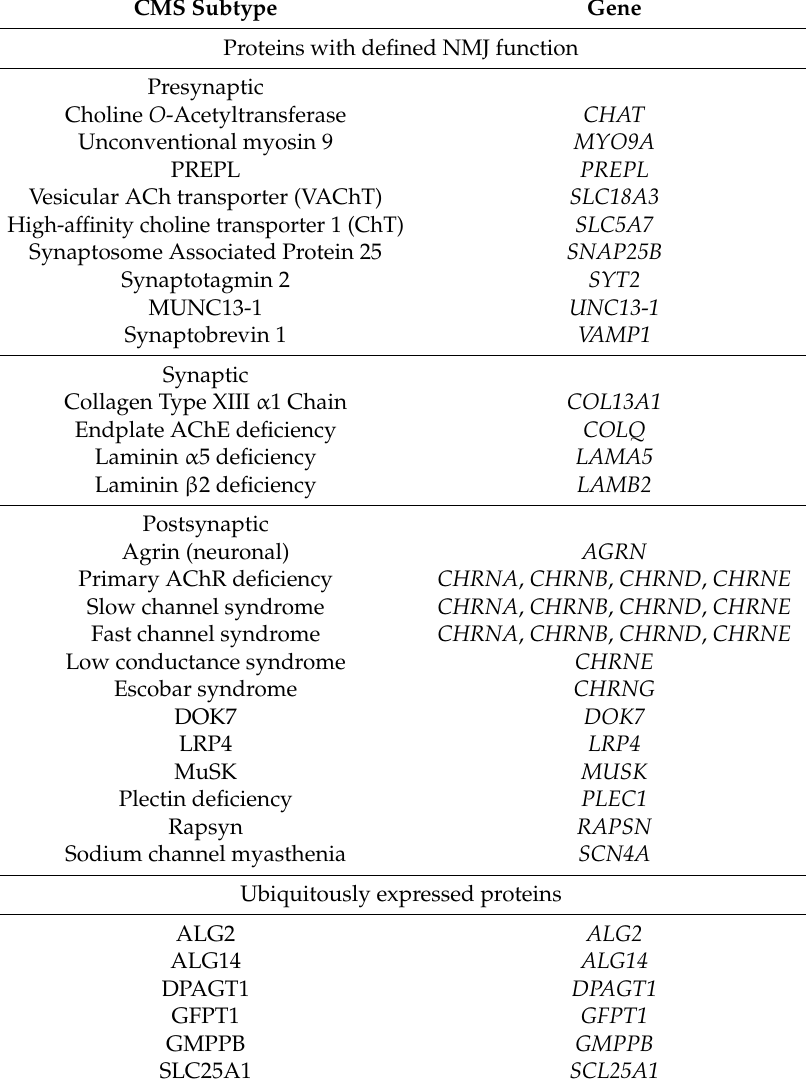
Table 1. CMS subtypes and associated